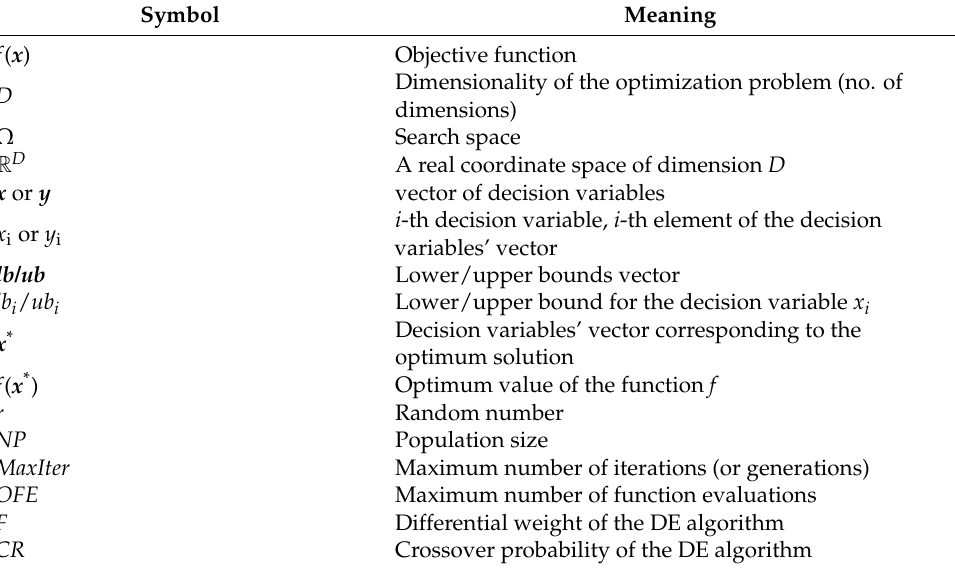
Table A2. Notation and symbols.